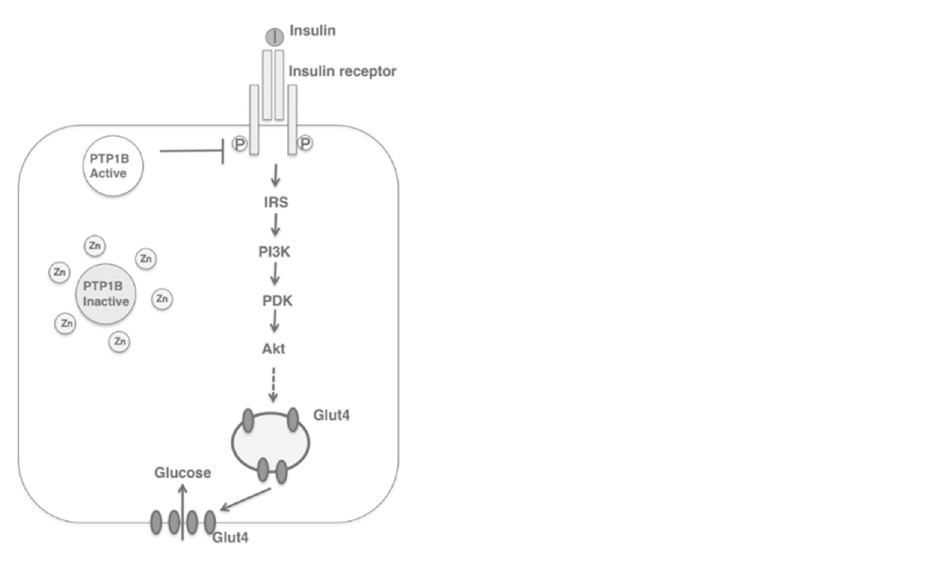
Figure 1. Zinc acting as an insulin-mimetic through its direct effect on the insulin-signaling pathway. IRS, insulin receptor substrate; PI3K, phosphatidylinosol-3-kinase; PKD, protein kinase D; Akt, protein kinase B [14].